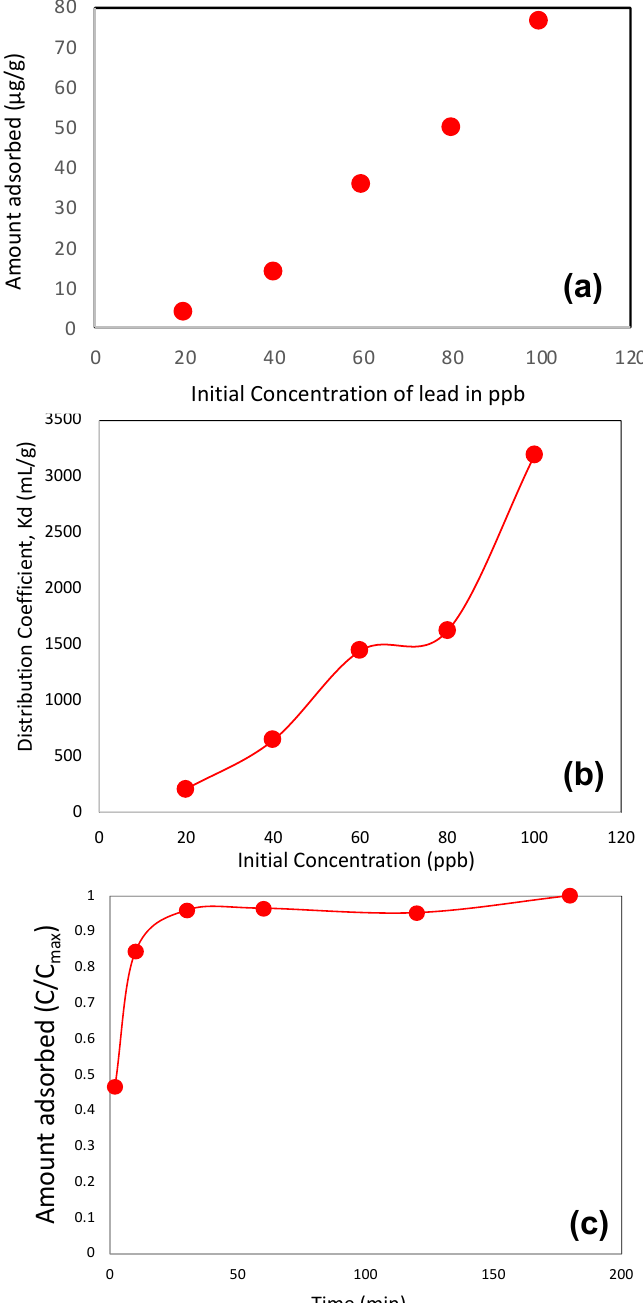
Figure 7. Pure Pb (II) adsorbed amount as a function of initial concentration; ( a ) distribution of coefficient (K d ) of pure Pb(II) as a function of initial concentration ( b ) and adsorption kinetics of pure Pb(II) ( c ). The kinetic studies were performed in batch mode with Pb(II) concentration 100 ppb ( 𝜇 g/L) and for all experiments, the adsorbent concentration was 1 g/L.